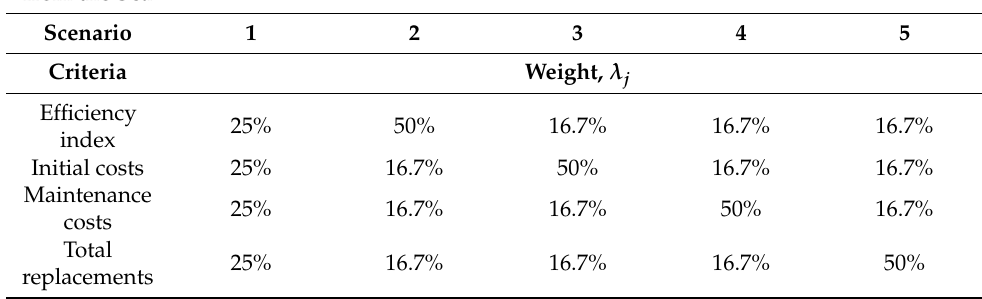
Table 5. Multi-criteria decision analysis for distance from the